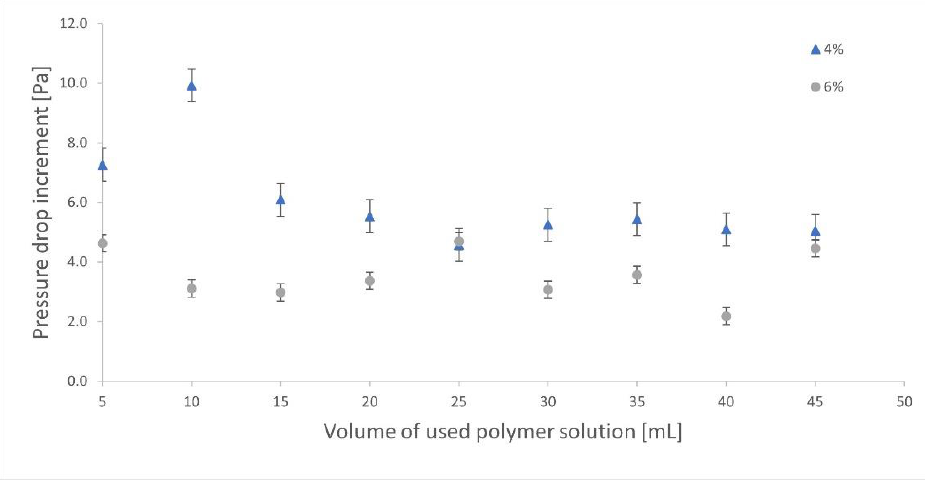
Figure 8. Pressure drop increment as a function of volume of used solution.